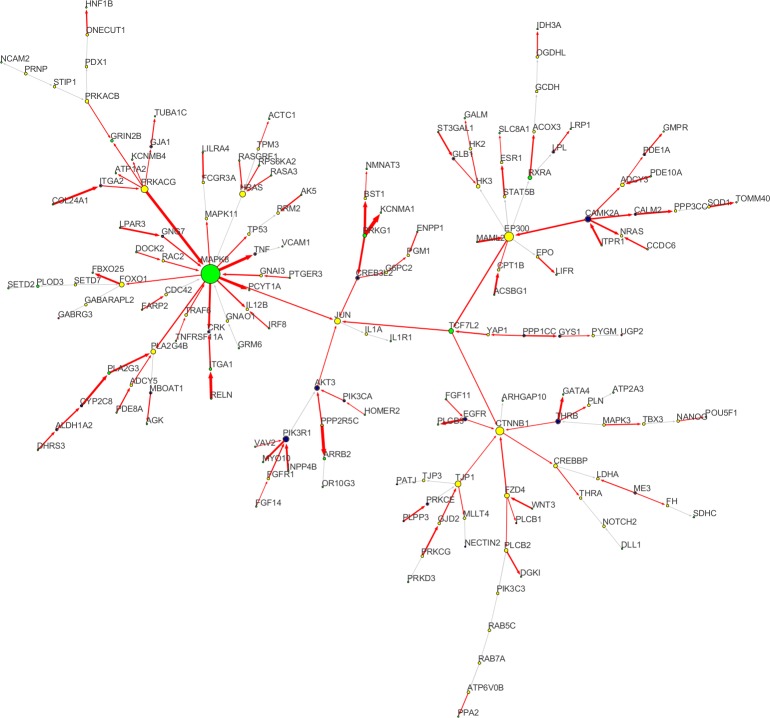
Steiner tree.Steiner tree obtained applying a Shortest Path Heuristic (SPH) algorithm. The tree has 167 nodes and 166 edges. The size of each node (i.e. gene) is proportional to its degree (i.e. the number of incoming and outgoing connections). Node colours indicate: perturbed seeds (green), non-perturbed seeds (red), perturbed connectors (blue), and non-perturbed connectors (yellow). Red edges correspond to perturbed interactions, while edge thickness is proportional to their weight (i.e. their perturbance level). A perturbed interaction has a weight w < 0.33 (i.e. p < 0.05 threshold over the nominal p-value). The entire network is characterized by a backbone CAMK2A-TCF7L2- CTNNB1-JUN-MAK8-PRKACG, where CAMK2A and MAPK8-PRKACG are the main perturbed hubs, CTNNB1 and JUN represent the sinks of the entire system, and TCF7L2 is the bottleneck connecting them.